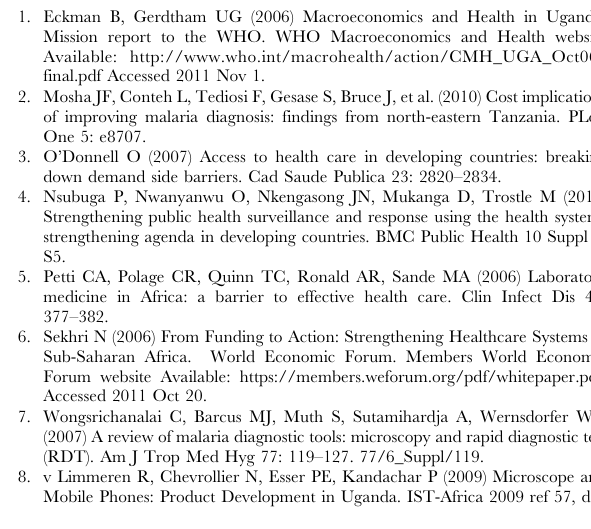
Figure 4. Data transfer system forms. Illustrated above is the test form on the end user’s mobile phone. The image below shows the website page model for receiving the data (image, sample type and locations specifications). Images can be enlarged on the site and comments to image sent back to the requester through a text message.